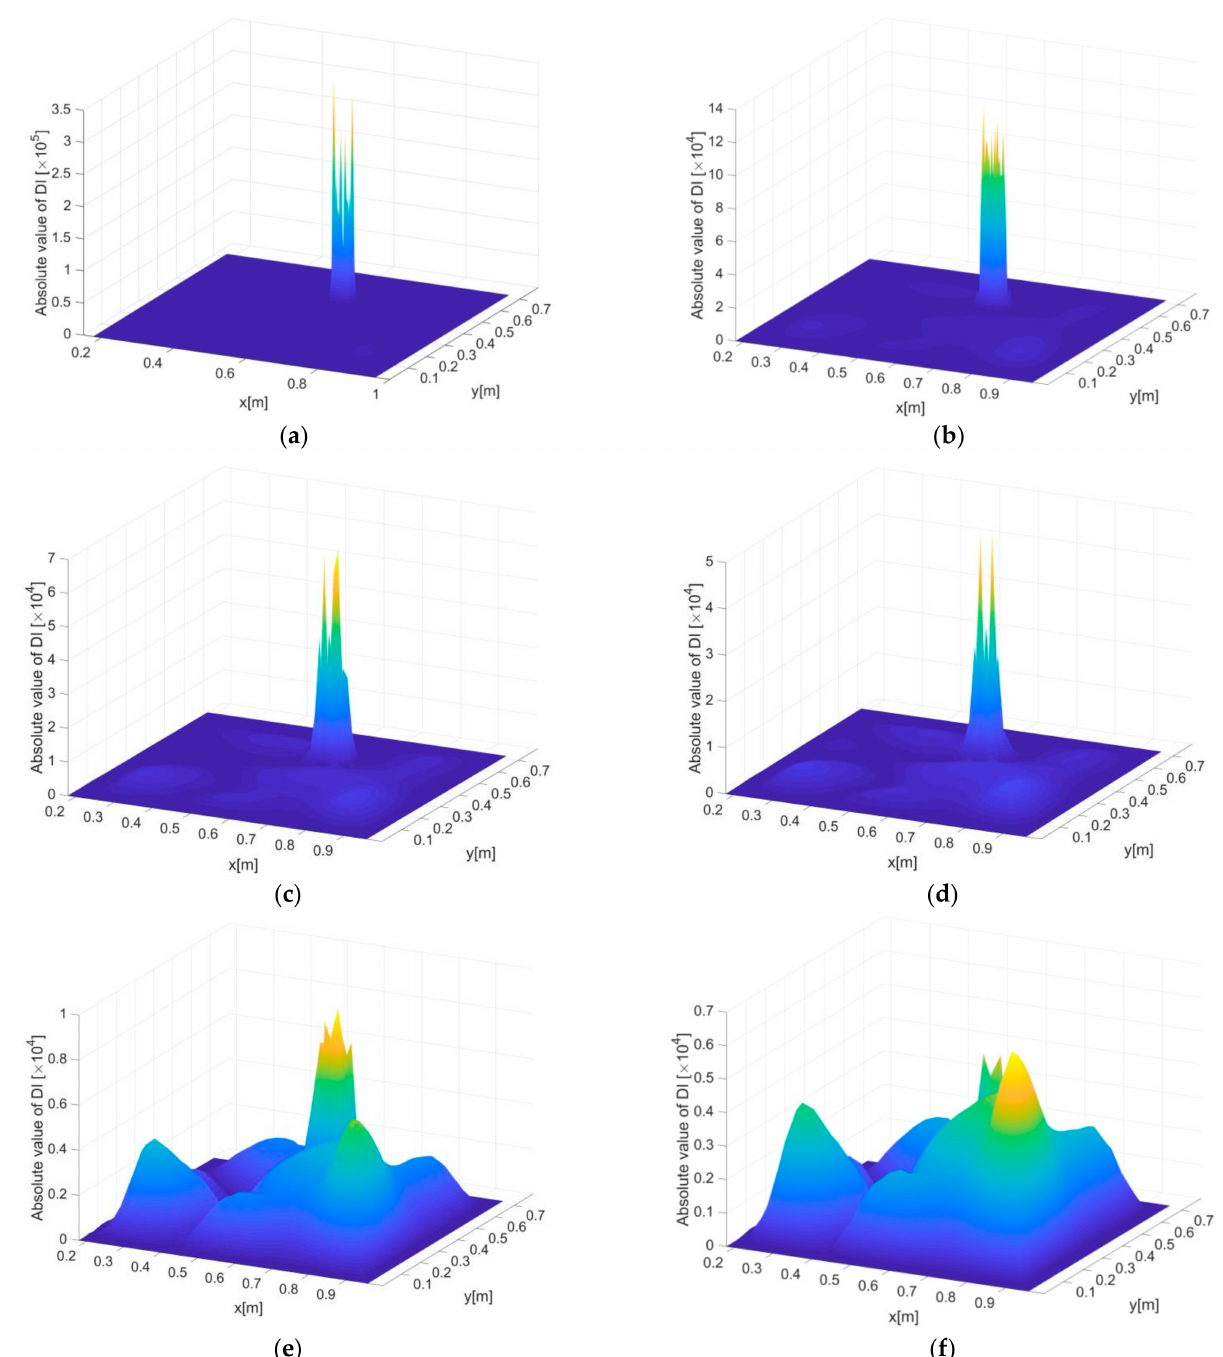
Figure 10. Delamination identification results using vibration displacements reconstructed by iFEM, subjected to an element size of ( a ) 3, ( b ) 6, ( c ) 12, ( d ) 15, ( e ) 24 and ( f ) 30 mm,